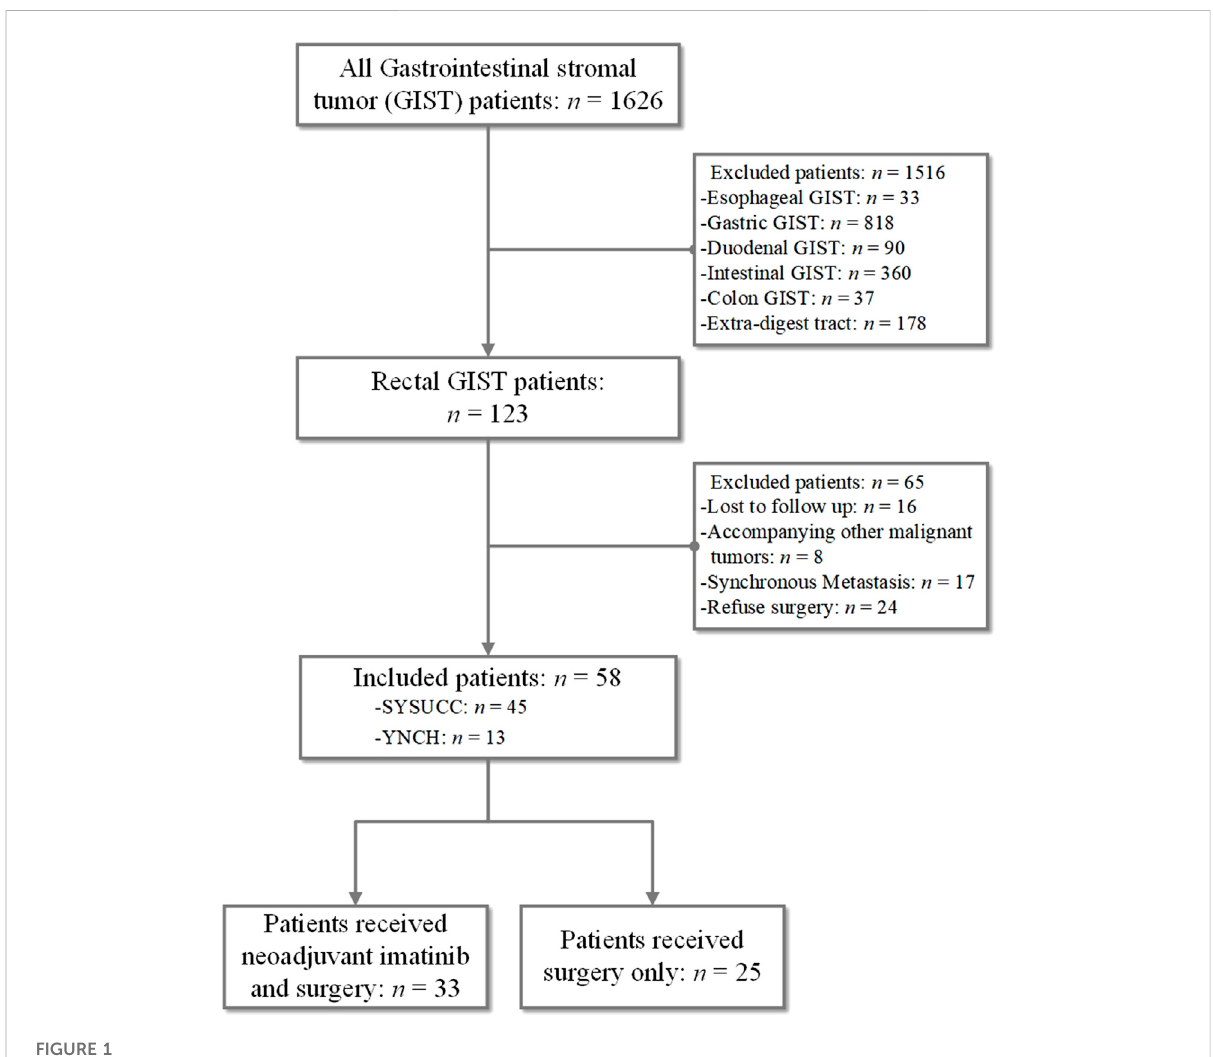
FIGURE 1 Flow chart of patient